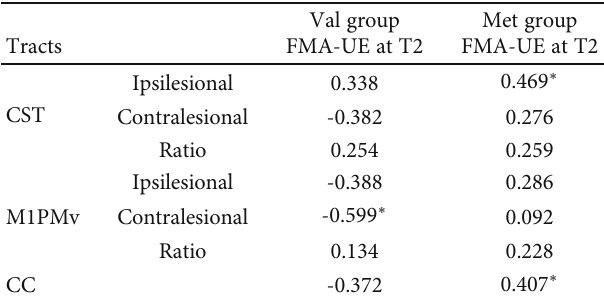
Each cell represents correlation coe ffi cients ( r ). FMA-UE: Fugl-Myer assessment, upper extremity score; CC: corpus callosum; CST: corticospinal tract; FA: fractional anisotropy; M1PMv: intrahemispheric corticocortical connection from primary motor cortex to ventral premotor cortex; T1: two weeks after stroke onset; T2: three months after stroke onset; ∗ P < 0 : 05 , ∗∗ P < 0 : 001